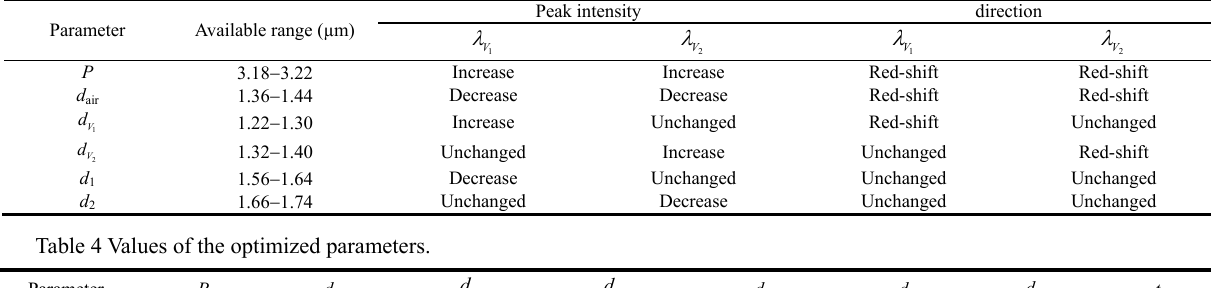
Table 3 Influence of different parameters on the loss peak.